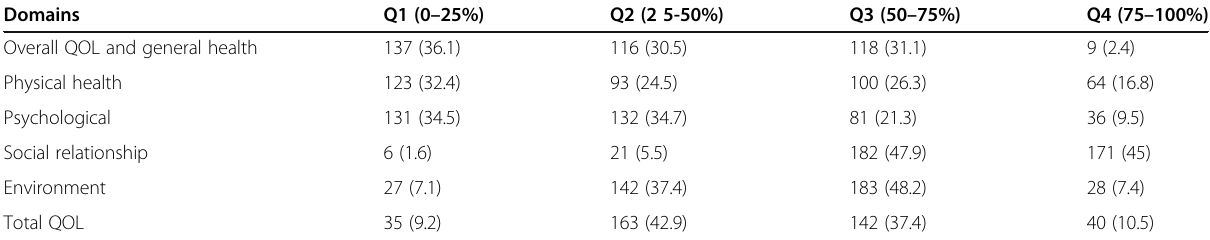
Table 2 Frequency (%) of QOL domains of the study sample based on Quartiles of WHOQOL-BREF score Domains